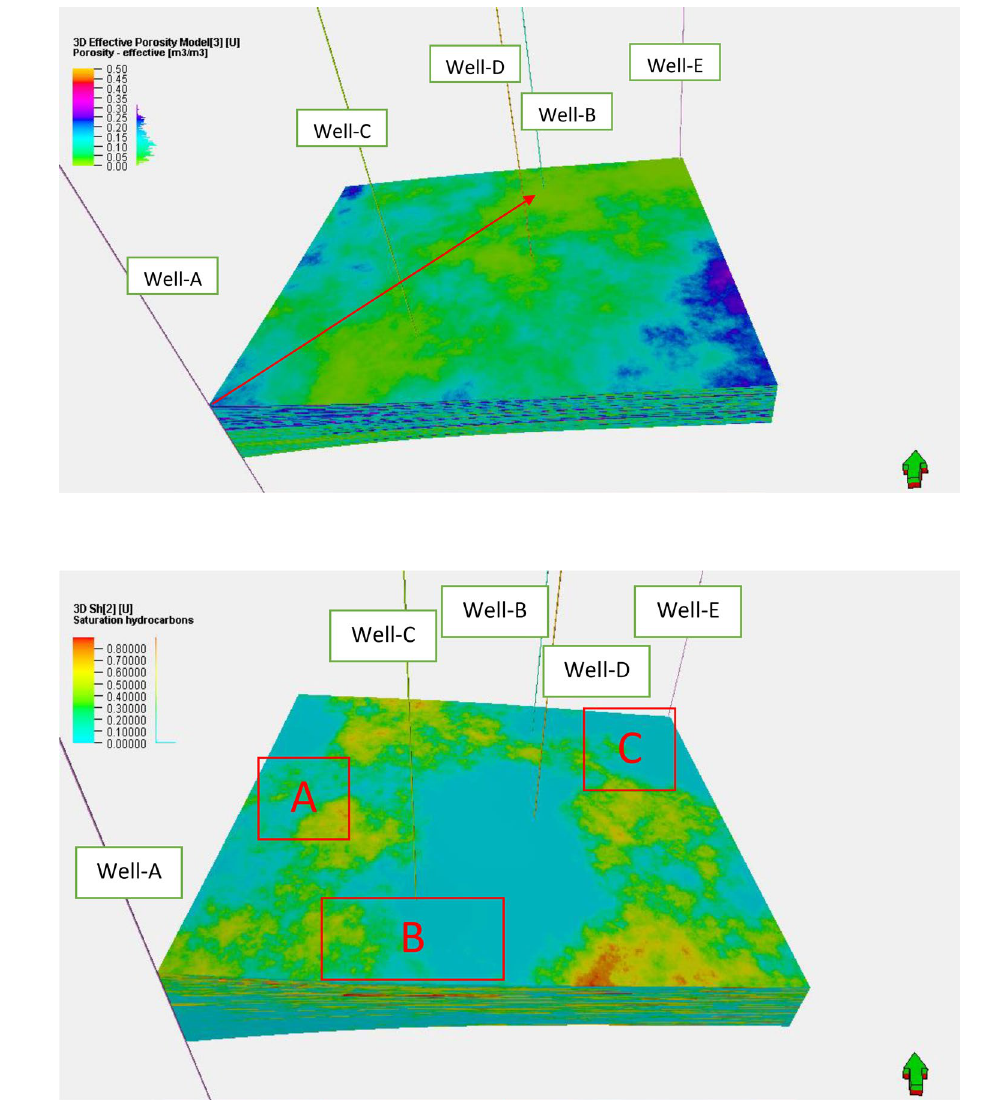
Fig. 18 3D effective porosity model of the studied reservoir